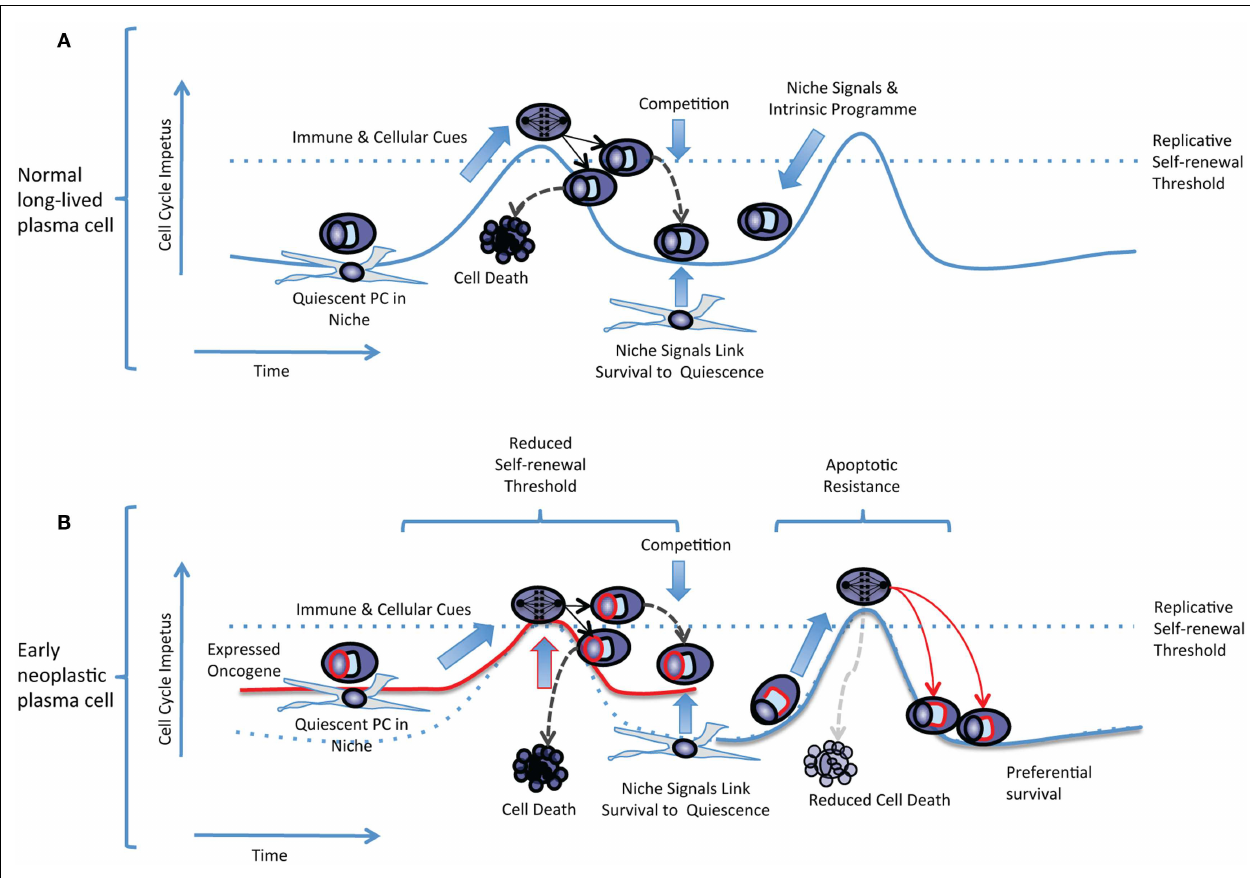
re-establishment of quiescence. Failure to compete for niche occupancy leads to cell death limiting population expansion. (B) In an early neoplastic plasma cell expression of an oncogene such as CCND1 (illustrated as a red line surrounding the “nucleus”) reduces the effective replicative self-renewal threshold by raising the steady-state level of cell cycle impetus. Dependence on immune and cellular cues still limits cell cycle re-entry, and niche dependence contributes to the re-establishment of quiescence. In an alternate non-mutually exclusive scenario expression of an anti-apoptotic oncogene (illustrated as a red line surrounding the “secretory apparatus”) leads to preferential survival of daughter cells but the normal replicative self-renewal threshold for cell cycle entry is